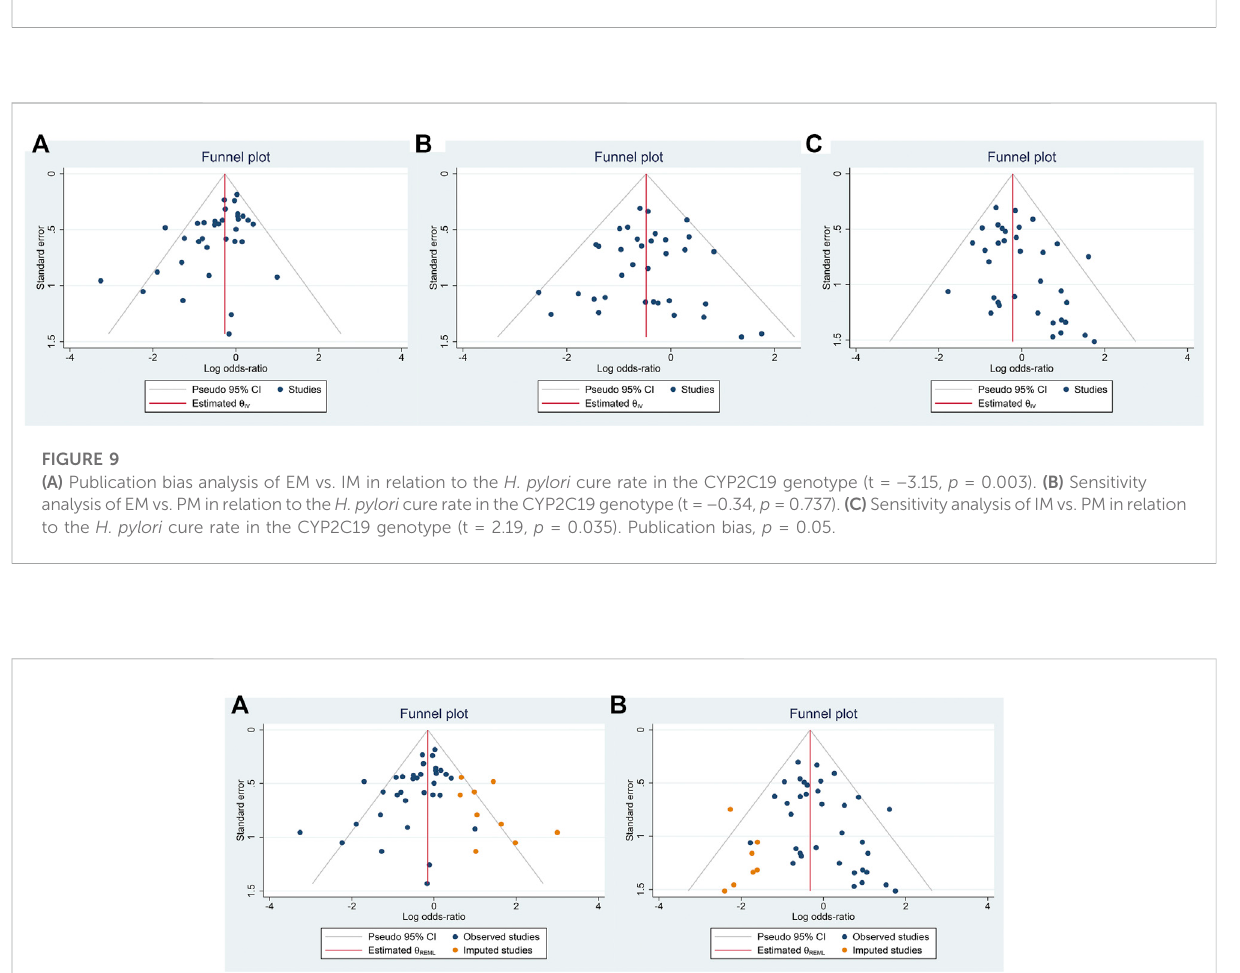
0.039, p Heterogeneity = 0.443). However, in Africa, there was a signi fi cant difference between EM and IM (66.4% vs. 80.2%, OR = 0.46, 95% CI: 0.24 – 0.90, p = 0.023, p Heterogeneity = 0.323), but neither between EM and PM (66.4% vs. 83.3%, OR = 0.47,